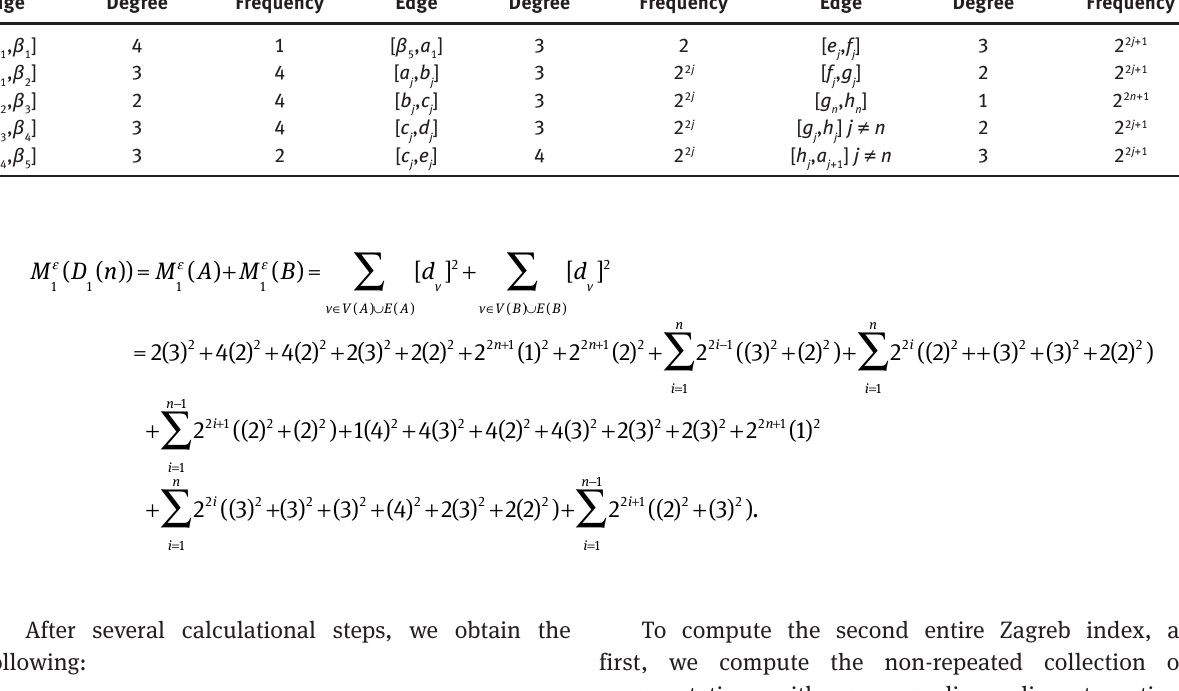
Table 2: The edge partition with respect to the pairs of end vertices of sets A and B , degree of each edge and their frequencies of occurrence.